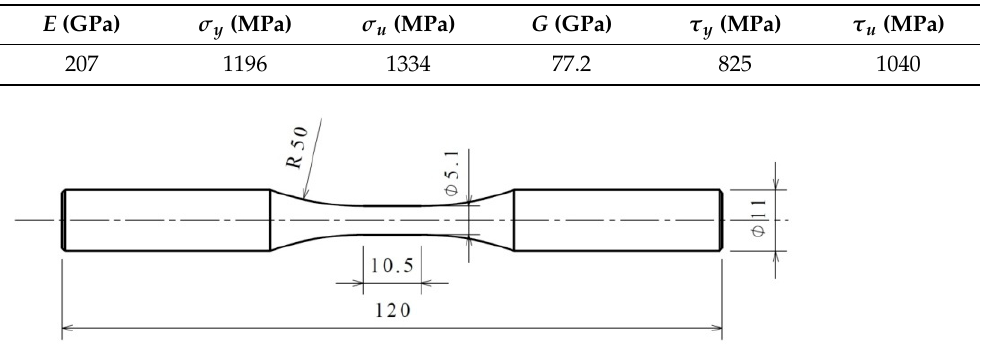
Table 2. Mechanical properties of 30CrMnSiA steel. (Reproduced with permission from Liu, Crack initiation and propagation of 30CrMnSiA steel under uniaxial and multiaxial cyclic loading, published by Elsevier, 2019).